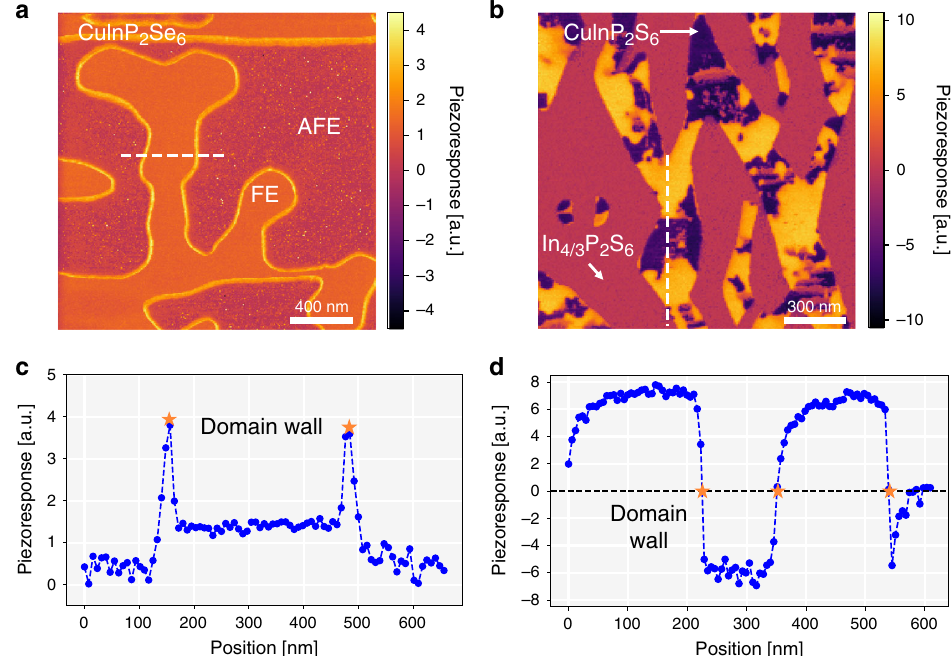
Fig. 1 Comparison of piezoresponse due to domains and domain walls in CuInP 2 Se 6 and Cu 0.4 In 1.2 P 2 S 6 . CuInP 2 Se 6 surfaces were measured at 140 K in ultrahigh vacuum and that of CuInP 2 S 6 — at room temperature in controlled environment: a , b piezoresponse signals A cos( θ ) (where A is the amplitude and θ the phase of piezoresponse) — revealing at least three distinct magnitudes of piezoresponse for both materials, and c , d line-pro fi les of piezoresponse along the white dashed lines, crossing domain boundaries in a , b , respectively. Orange arrows point to the regions of the domain walls.